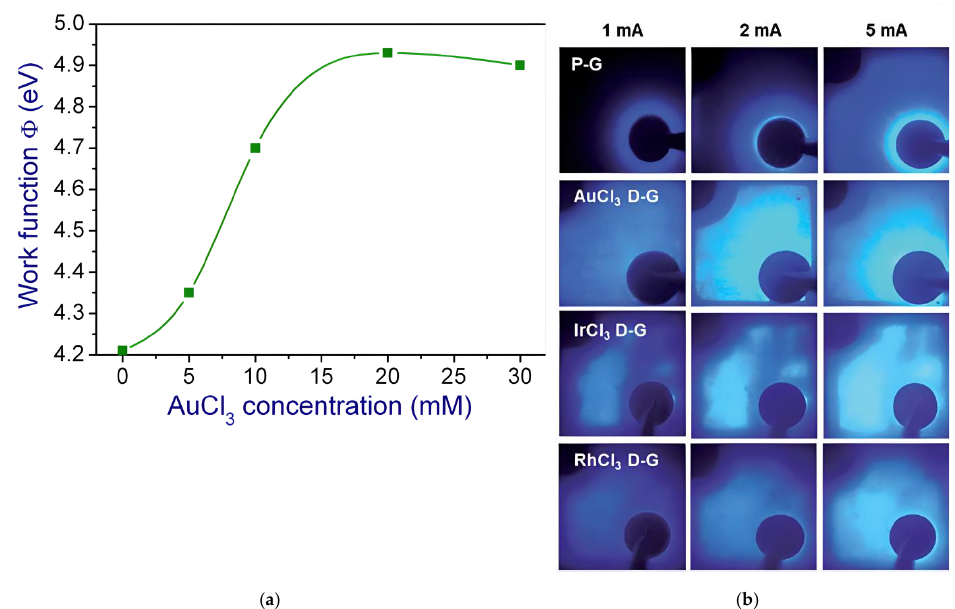
Figure 7. Graphene doped with metal-chlorides integrated as TCSL into GaN-based MQW LEDs: ( a ) work function of doped graphene films as function of AuCl 3 concentration; ( b ) light emission images in a typical LED device with different dopants in graphene, namely AuCl 3 , IrCl 3 and RhCl 3 compared to pristine graphene (P-G) from top to bottom, and at various current levels, namely 1 mA, 2 mA and 5 mA from left to right. ( a ) Reproduced with permission from [73]. Copyright 2012 IOP Publishing Ltd. ( b ) Reproduced with permission from [38]. Copyright 2014 The Royal Society of